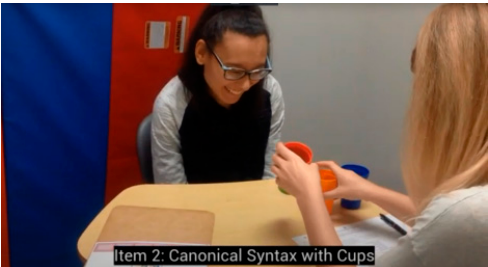
Movie 1. Most ASD (autism spectrum disorder) participants were able to complete the canonical stacking cups task (e.g., “Put the red cup inside the green cup”), but were unable to complete the same task under the condition of non-canonical word order (“Inside the green cup, put the red cup”). Failing ASD participants usually selected the correct cups, but assembled them randomly.